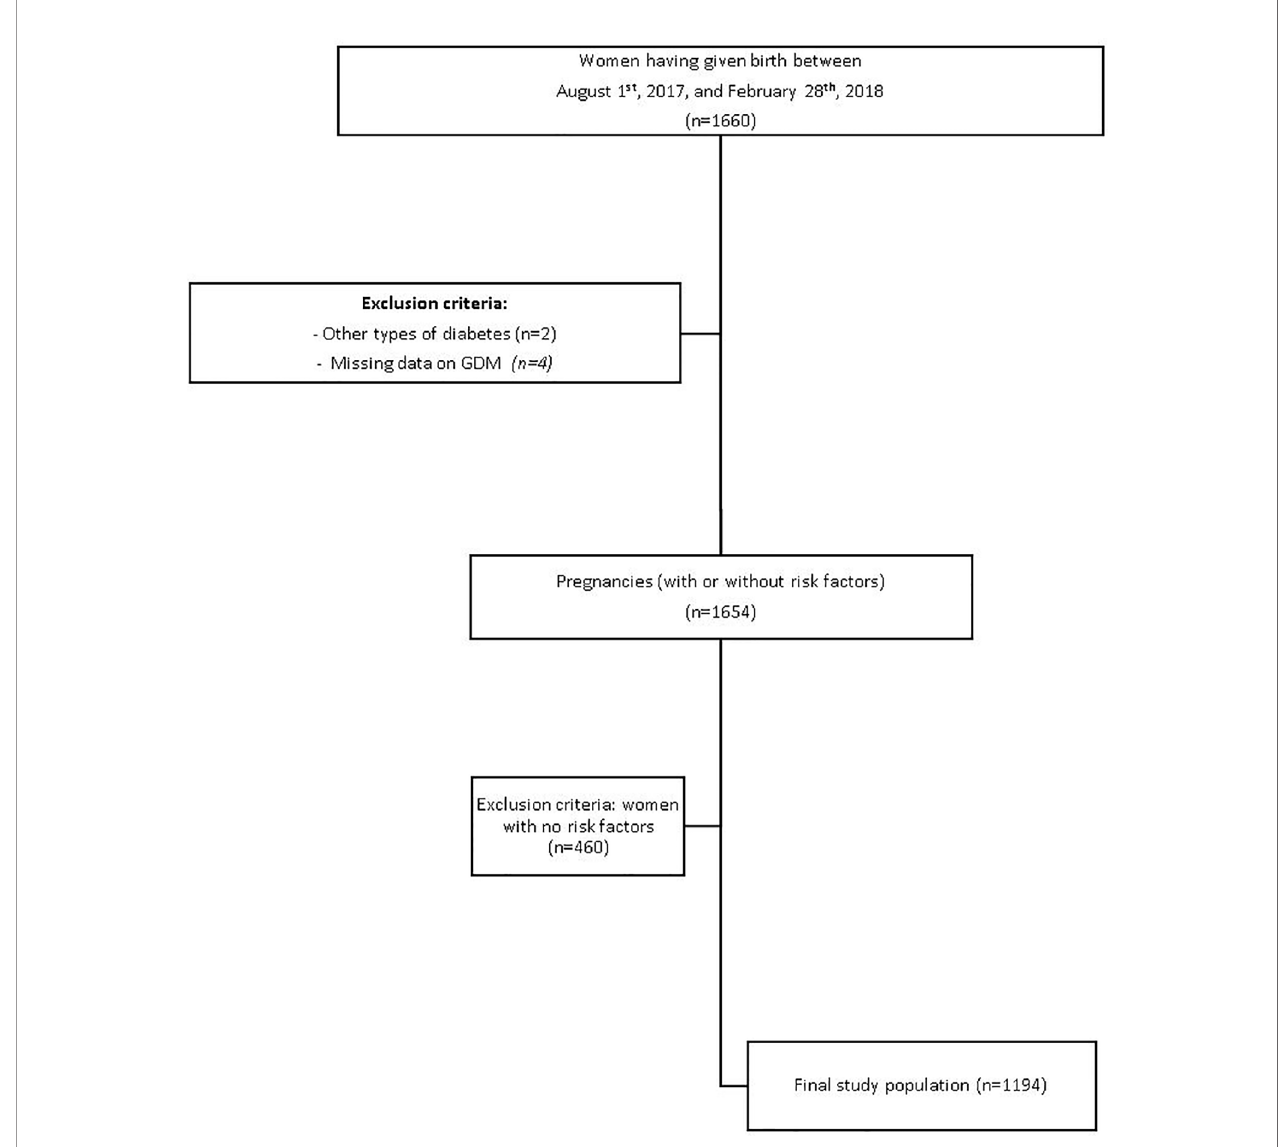
FIGURE 1 | Study fl ow